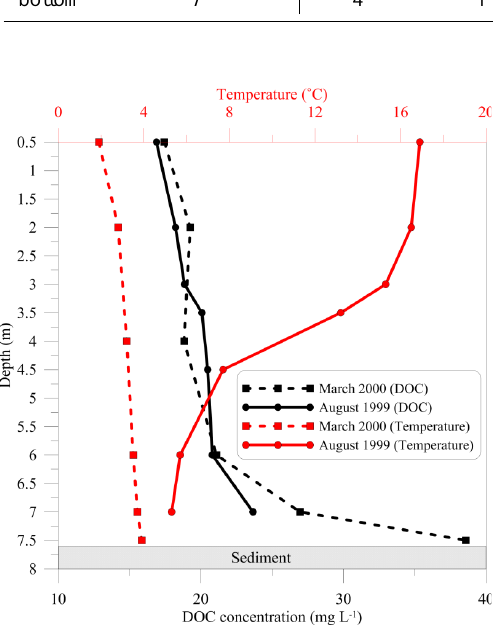
Fig. 2. Depth profiles of DOC and temperature in Lillsjön Lake in 24 August 1999 (summer) and 7 March 2000